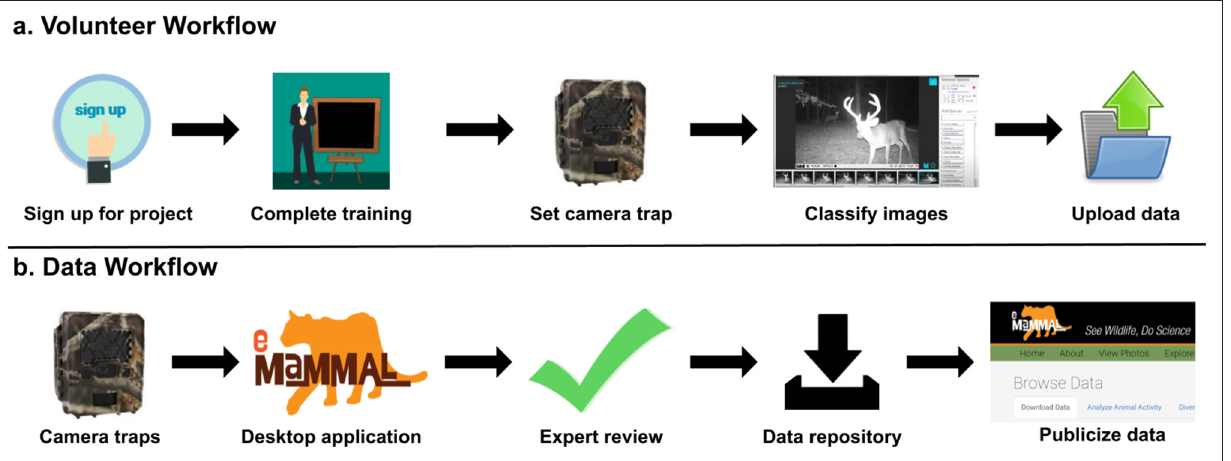
Figure 2 (a) Potential volunteers signed up on the North Carolina’s Candid Critters website, went through training, deployed a camera, identified species in photos, then uploaded photos to eMammal. (b) Camera trap data were uploaded by volunteers to eMammal and were then reviewed and validated by expert biologists before being archived into the Smithsonian Digital Repository. The data in this repository was then made available on the eMammal